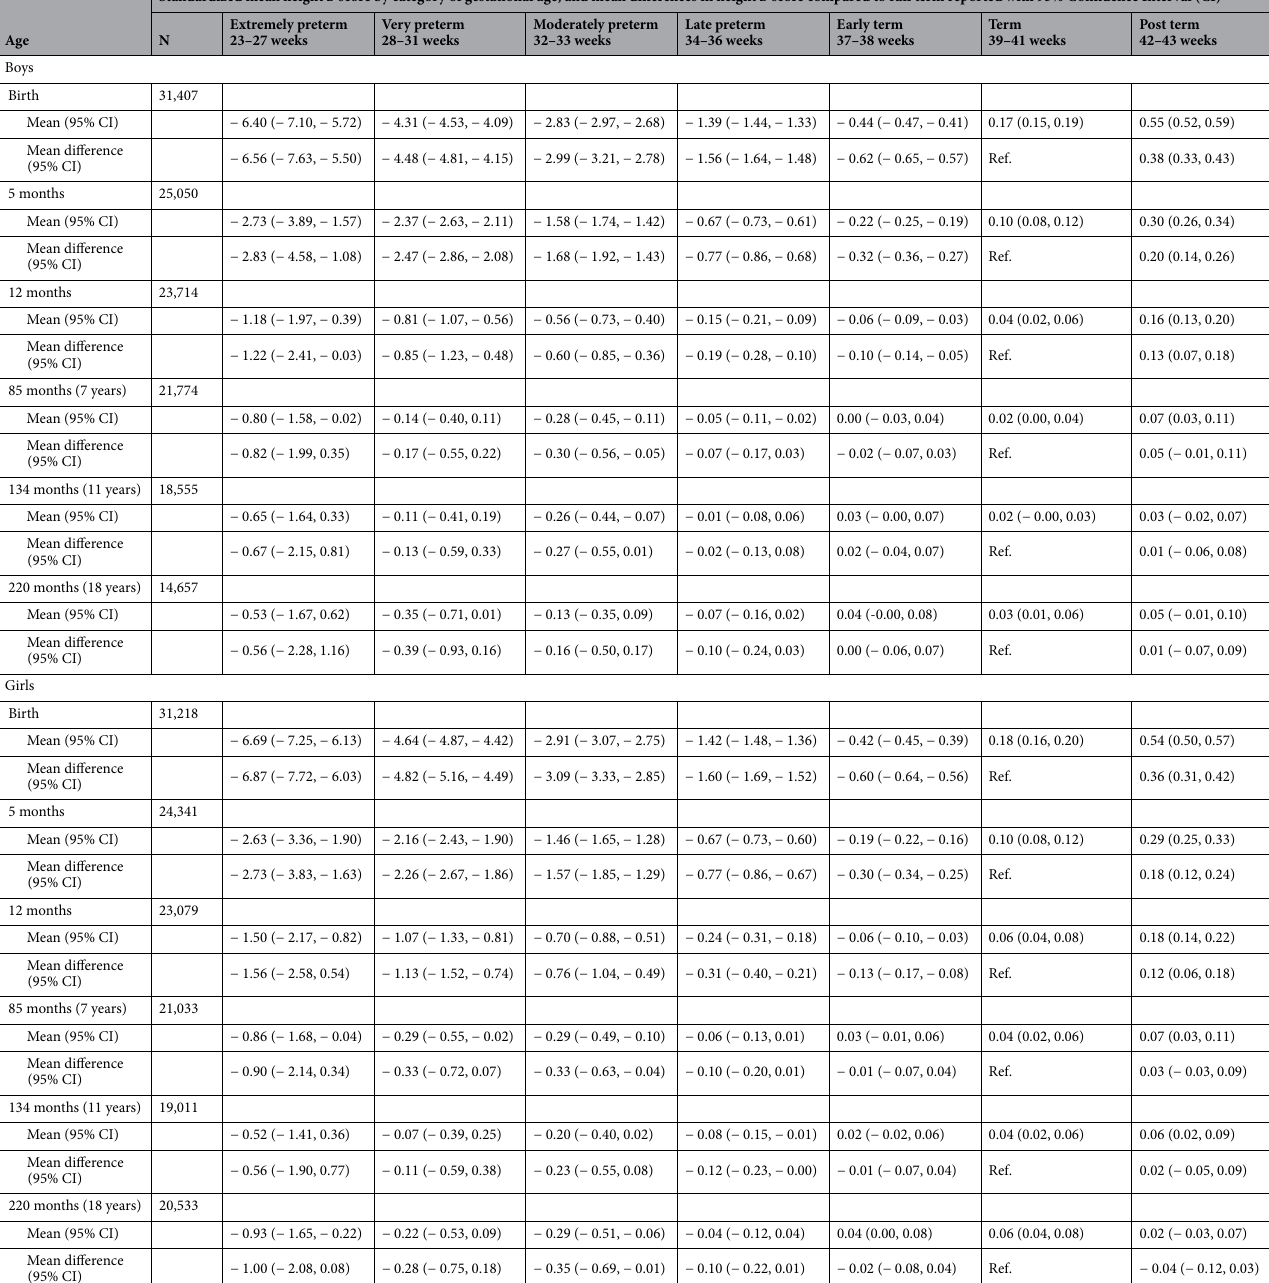
Standardized mean height z-score by category of gestational age, and mean differences in height z-score compared to full term reported with 95% Confidence Interval